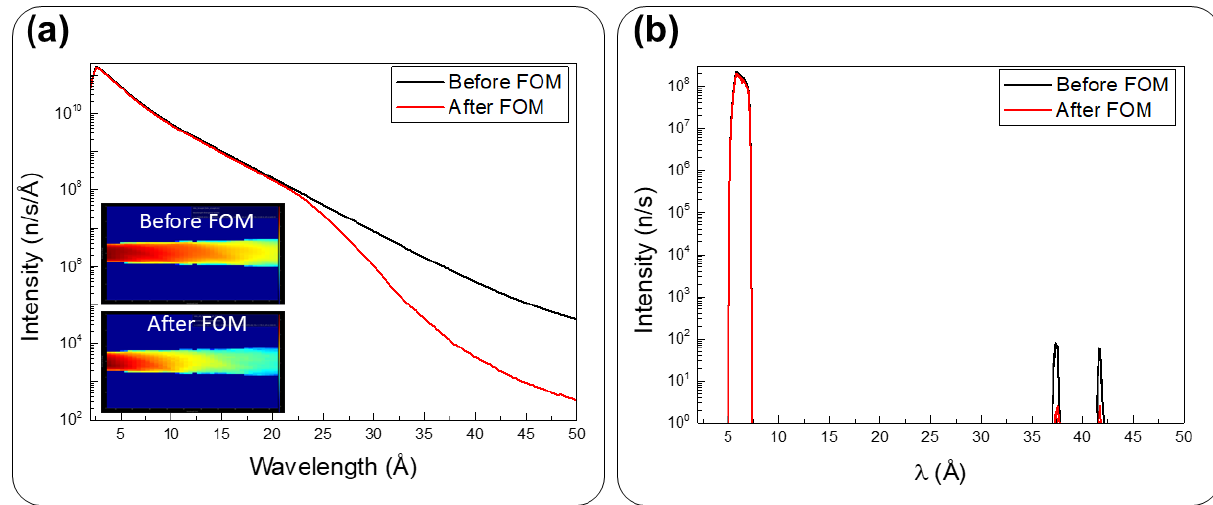
Figure 8. ( a ) Effect of the reduction of the long-wavelength neutrons by setting a frame overlap mirror with a cut-off wavelength of about λ ∼ 25 Å. Inset: the wavelength dependence of neutron flux and vertical divergence before and after the frame overlap mirror (FOM); the scales are λ = [25, 45] Å for the x-axes, ∆𝜙 (cid:3023) = [–3, 3]° for the y-axes and [0, 6]·10 6 n/s for the color scale. ( b ) Same case for choppers running at the high-resolution mode ( f = 224 Hz, δ E =2 μ eV), tuned for λ = 6.27